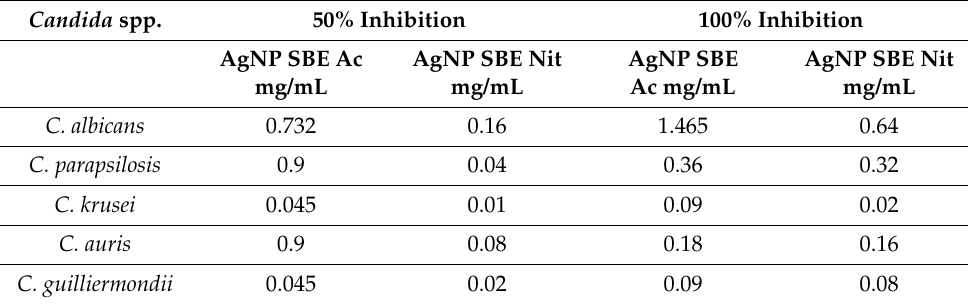
Table 1. Antifungal activity (MIC) of AgNP SBEs for Candida spp. Candida